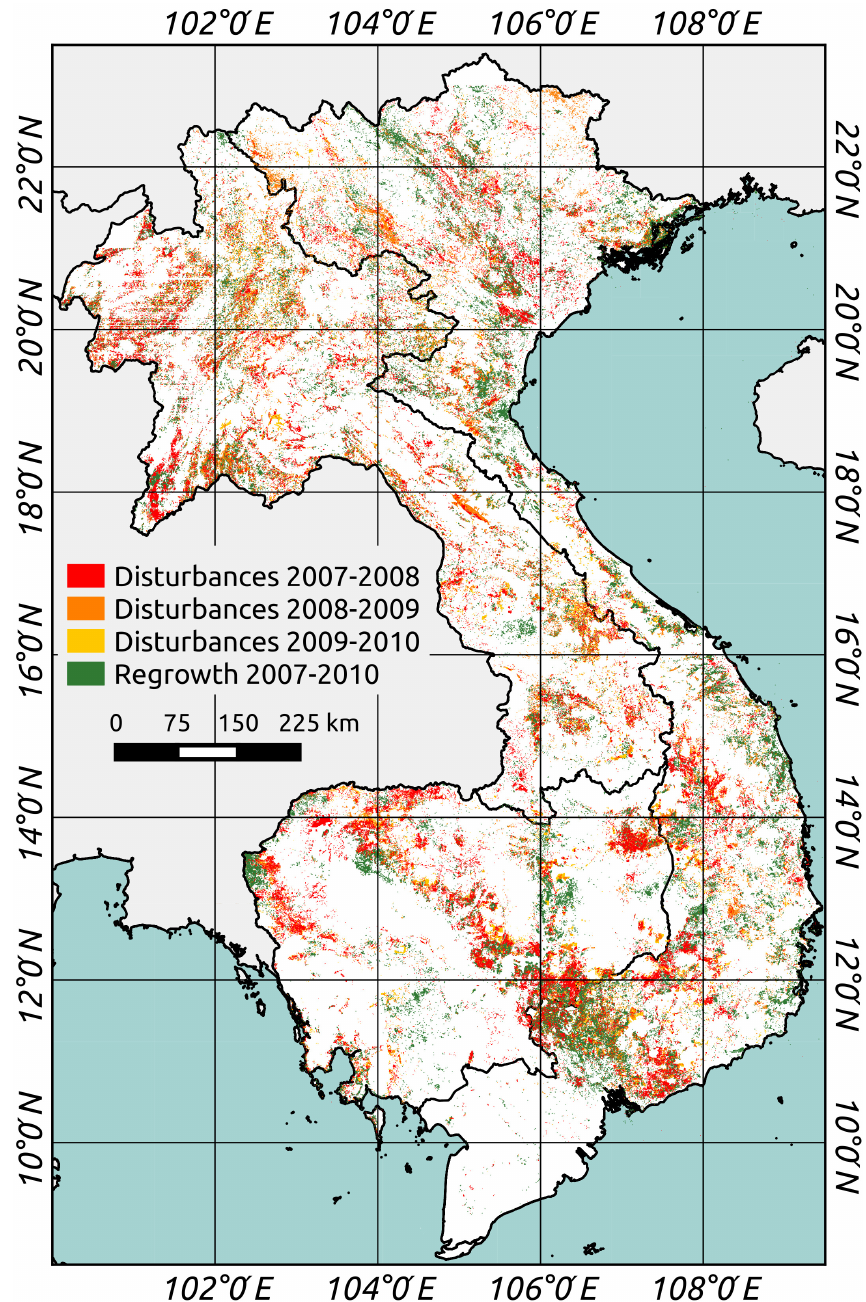
Figure 7. Forest disturbances and regrowth maps between 2007 and 2010 over Vietnam, Cambodia and Lao PRD at 25-m